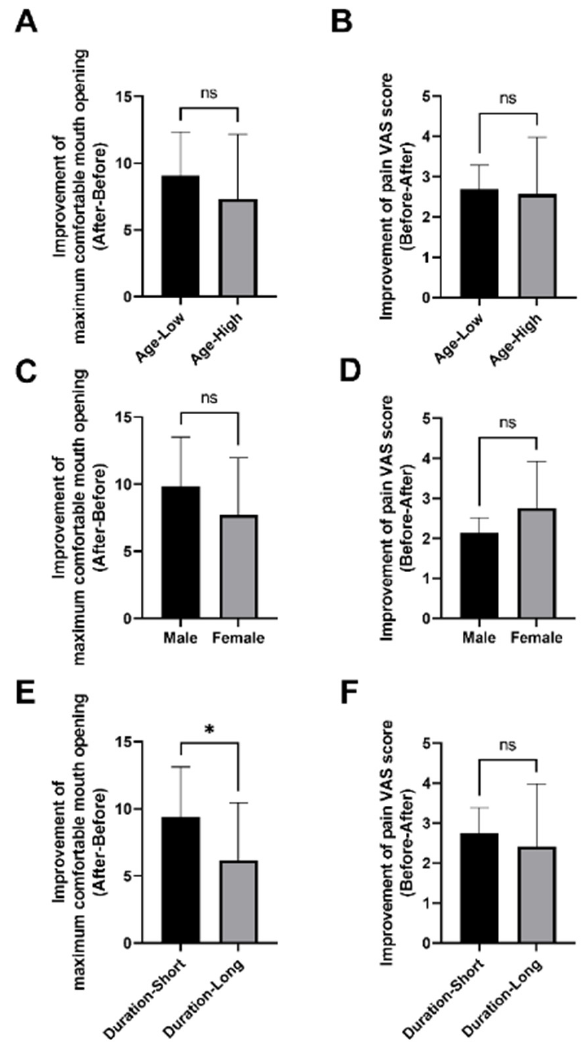
Figure 5. Statistical results of age, sex and duration. ns: no significance; *: p < 0.05. ( A ) Improvement of maximum comfortable mouth opening; ( B ) Improvement of pain VAS score; ( C ) Improvement of maximum comfortable mouth opening; ( D ) Improvement of pain VAS score; ( E ) Improvement of maximum comfortable mouth opening; ( F ) Improvement of pain VAS